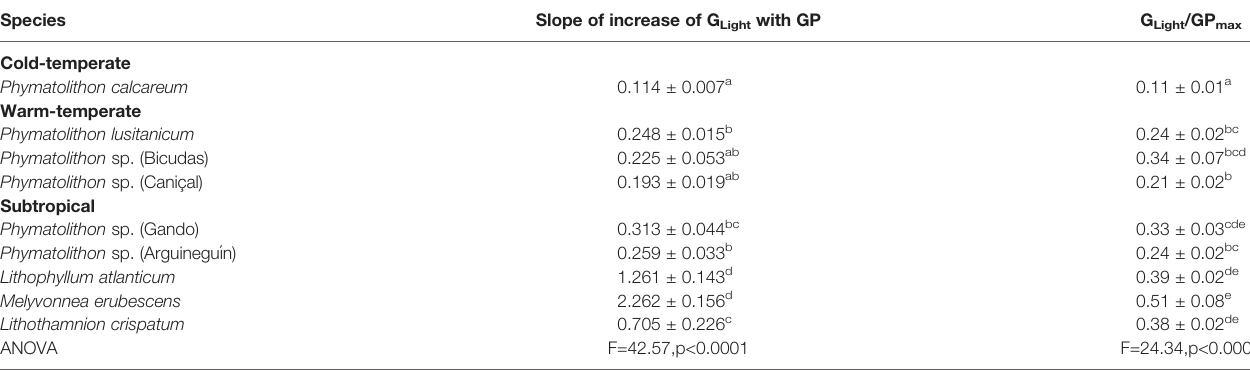
Table Legend: Initial linear slope of the increase of calci fi cation with photosynthesis at irradiances <E k (mol O 2 precipitated mol -1 CaCO 3 ) and mean ratio of maximum light calci fi cation (G